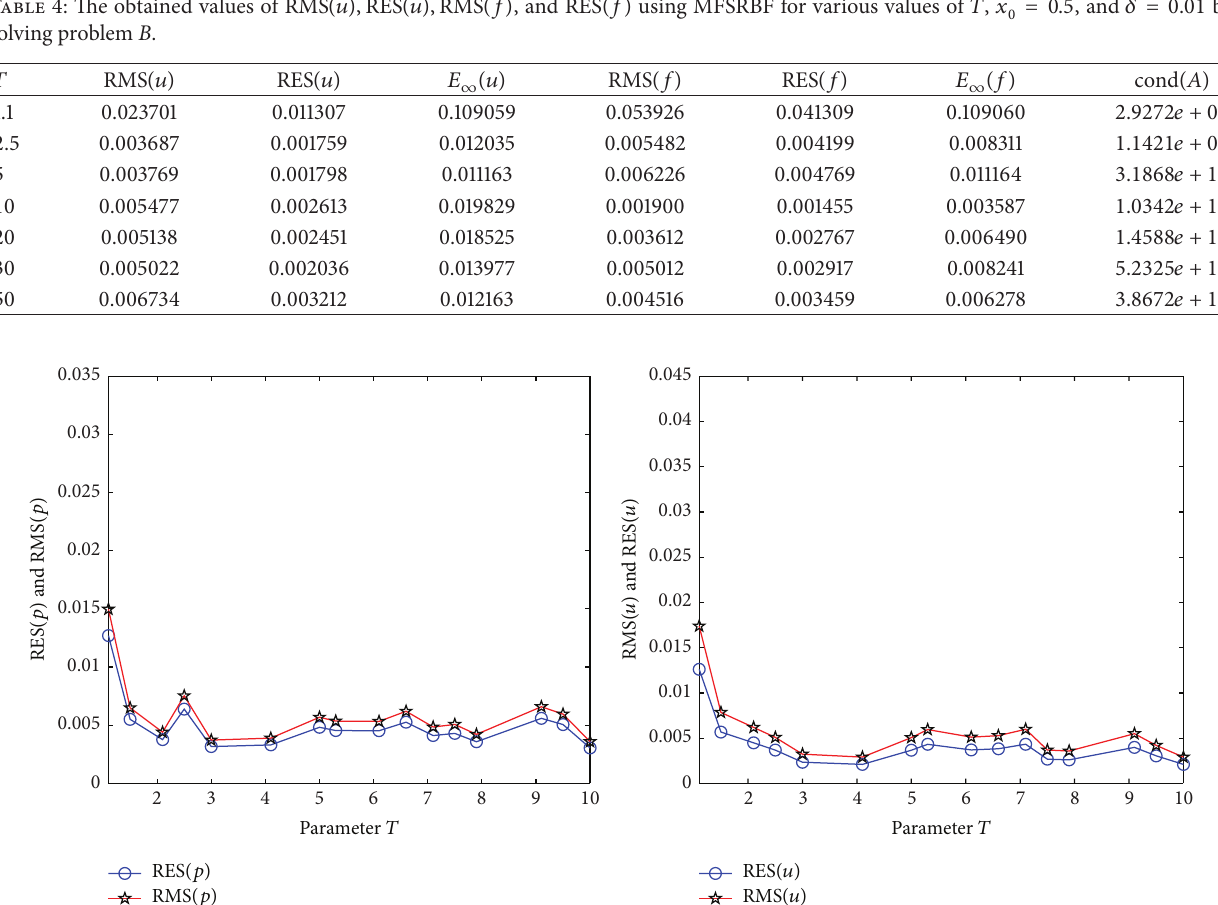
Figure 2: The accuracy of the obtained numerical results by MFSRBF for 𝛿 = 0.01 and 𝑥 0 = 0.5 with respect to the parameter 𝑇 .